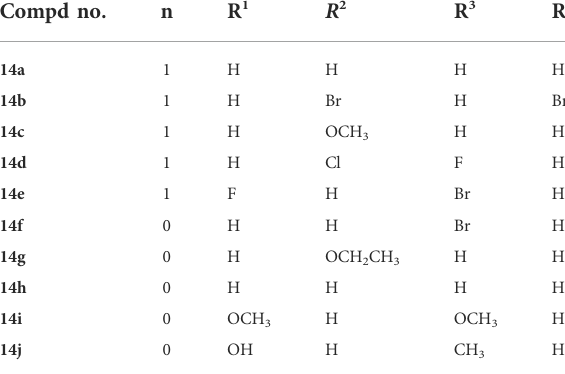
TABLE 1 The structures of erlotinib-1,2,3-triazole derivatives. Compd no.